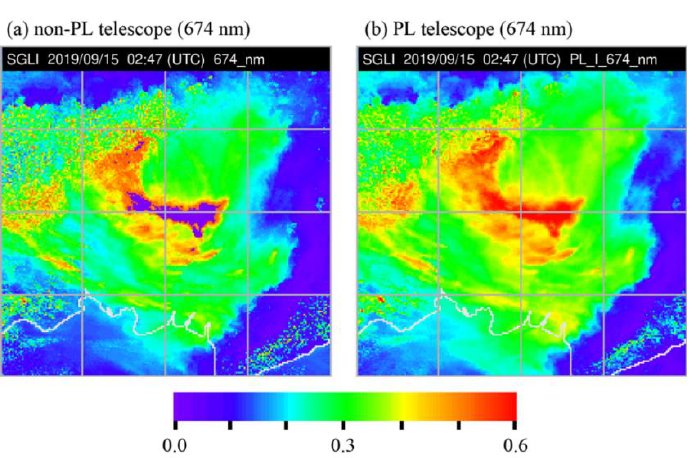
Figure 5. ( a ) Nonpolarization band (674 nm) and ( b ) polarization band (PL1; 674 nm) measurements by the second-generation global imager (SGLI) over Kalimantan, Indonesia on 15 September 2020.